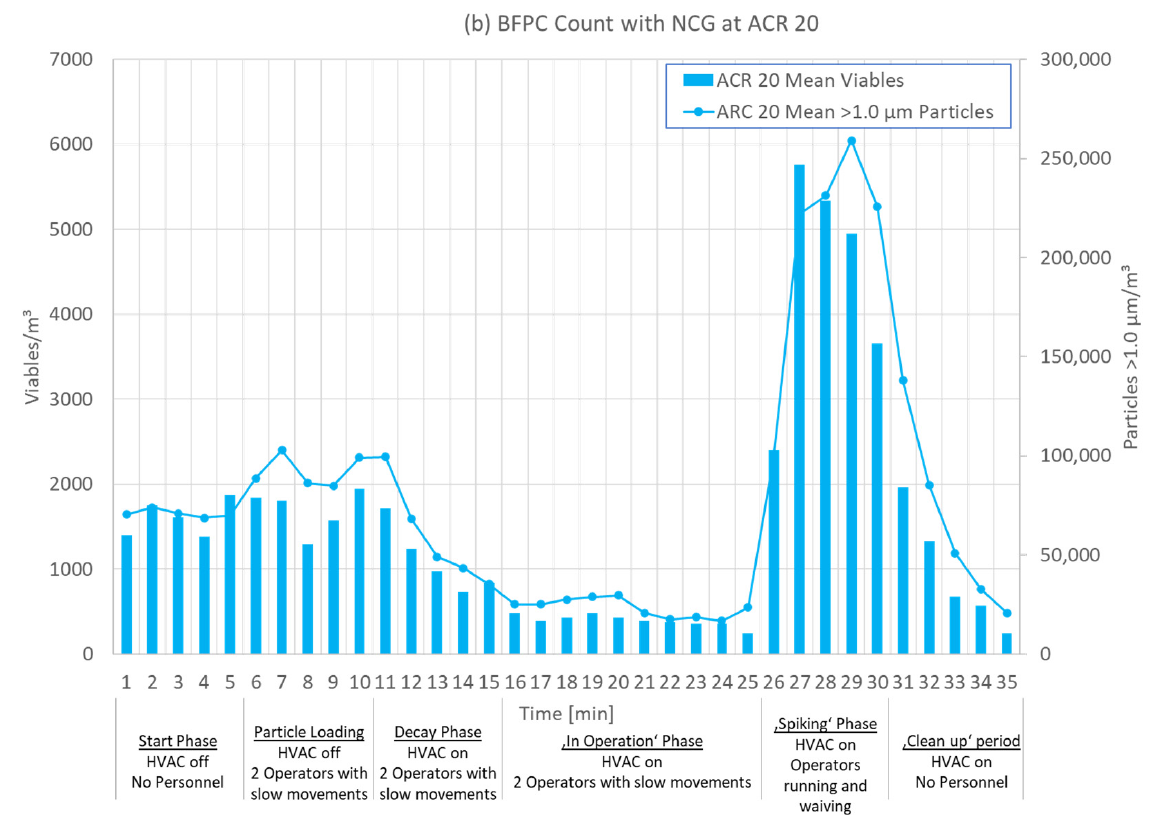
Figure 4. Particles and Viables/m 3 in the different test phases at ACR 20: ( a ) with I8G/( b ) with NCG (Note the different scale on x-axes in ( b ) to reflect the spiking phase).